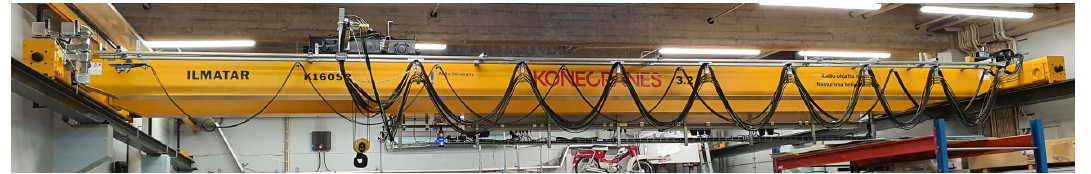
Figure 2. Overhead crane Ilmatar at Aalto University Industrial Internet